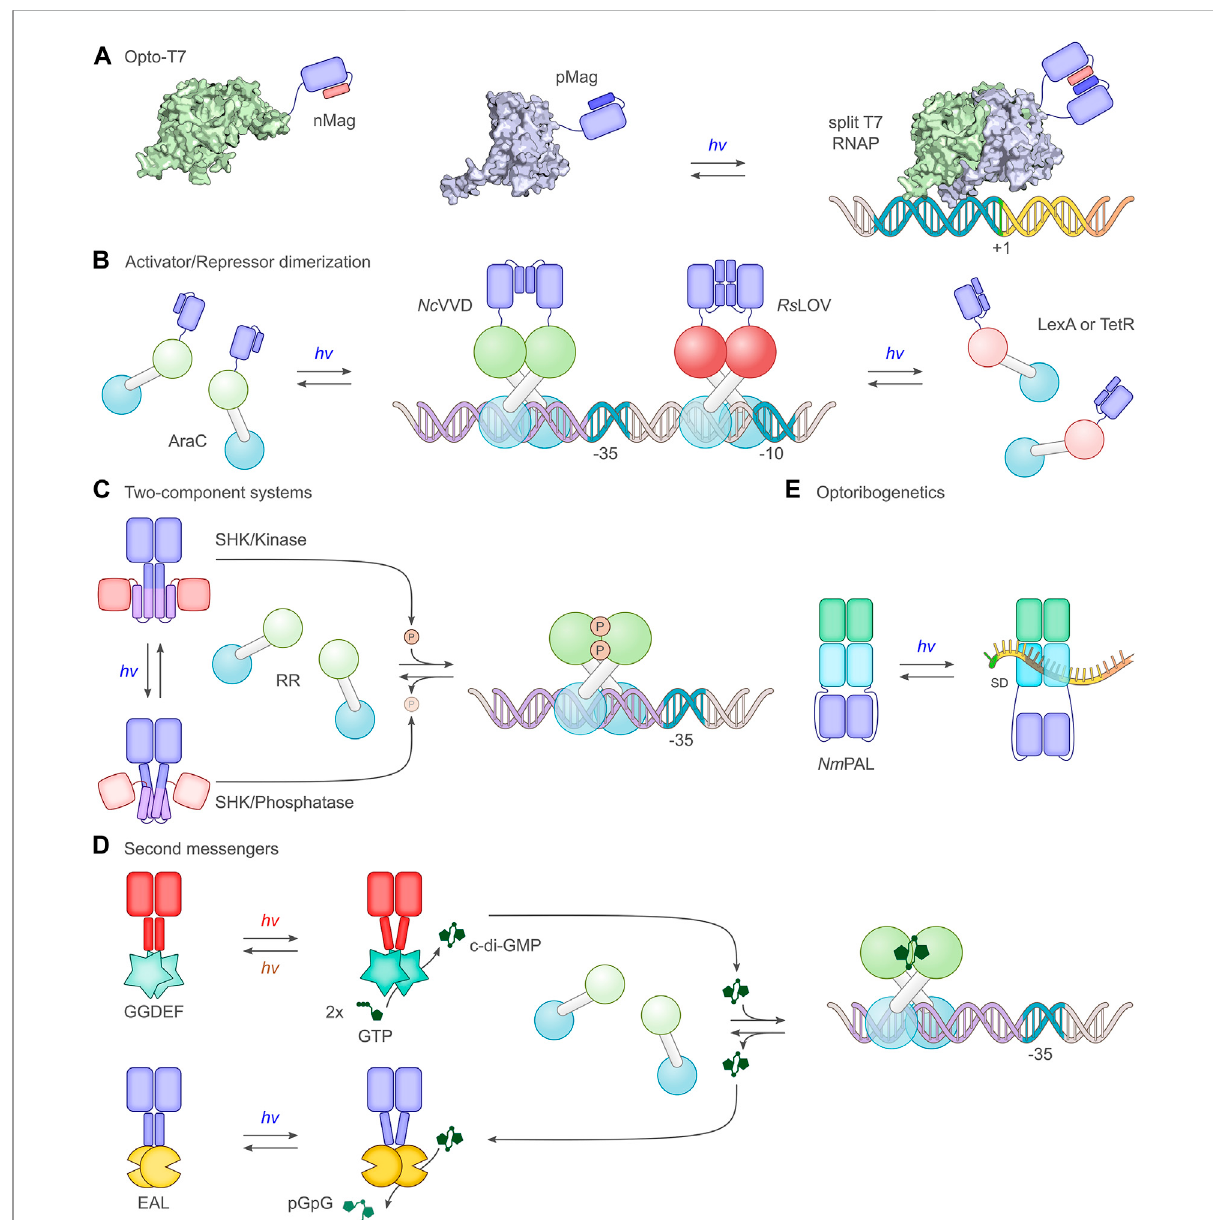
FIGURE 4 Select principal strategies for the light-dependent control of gene expression. (A) The phage-derived T7 polymerase can be dissected into two parts which in separation have little activity. By fusing the polymerase fragments to photoassociating LOV domains, such as the Magnets (Kawano et al., 2015), T7 can be reconstituted under blue light, and transcription ensues (Baumschlager et al., 2017; Han et al., 2017). (B) A group of strategies exploit the homodimeric nature of bacterial activator and repressor proteins. Via truncation, dimerization can be impaired, thus rendering monomers with little DNA af fi nity, let alone regulatory effects. As in strategy A, linkage to photoassociating LOV modules, such as N. crassa Vivid ( Nc VVD) (Zoltowski and Crane, 2008), allows dimerization and activity to be regained upon blue-light exposure. For instance, the widely used AraC transcriptional activator was subjected to light control thus (Romano et al., 2021). In a similar vein, repressor proteins such as LexA (Li et al., 2020) or TetR (Dietler et al., 2021) can be monomerized through truncation and linked to the photodissociating R. sphaeroides LOV domain ( Rs LOV) (Conrad et al., 2013). Light exposure leads to a dissociation of the LOV-linked repressor and hence to transcriptional activation. (C) A large group of studies (Levskaya et al., 2005; Tabor et al., 2011; Ohlendorf et al., 2012) employ two-component systems, consisting in their canonical form of a sensor histidine kinase (SHK) and a response regulator (RR). Depending on illumination, photoresponsive SHKs adopt kinase-active or phosphatase-active states (Möglich, 2019), thus promoting RR phosphorylation and dephosphorylation, respectively. Once phosphorylated, the RR serves as a transcriptional activator at target promoters. As depicted in the scheme, certain SHKs act as net kinases in their dark-adapted states before being converted to their phosphatase-active states by light (Levskaya et al., 2005; Möglich et al., 2009), while other SHKs are phosphatase-active in darkness and become kinase-active under light (Tabor et al., 2011). (D) Several optogenetic strategies are based on cyclic-nucleotide second